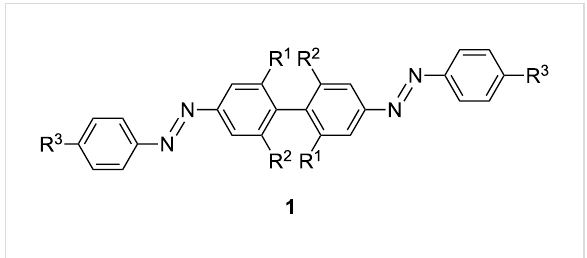
Figure 1: para -Substituted bisazobiphenyls 1 investigated by Hecht (R 1 , R 2 = H, Me, R 3 = t -Bu) and by Woolley and co-workers (R 1 = H, SO 3 Na, R 2 = H, R 3 = NHCOCH 3